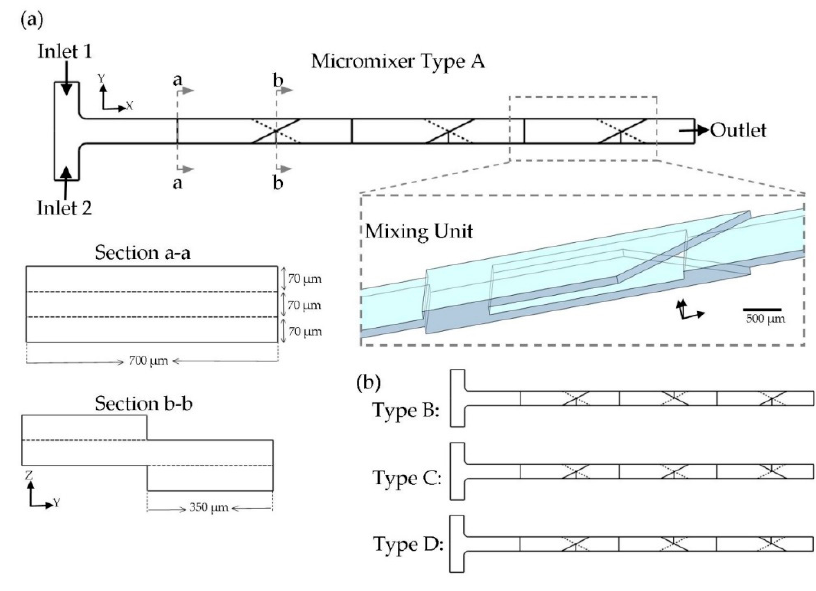
Figure 1. An overview of the geometry of the proposed micromixer. ( a ) Design of the micromixer compromising of three identical mixing units (Type A); 3D view of the mixing unit is illustrated. Furthermore, cross section views of the fluid splitting and recombining zone are illustrated. ( b ) Other three types of mixing units sequence, which was studied in this paper. Dashed lines are used to represent the rear triangle.